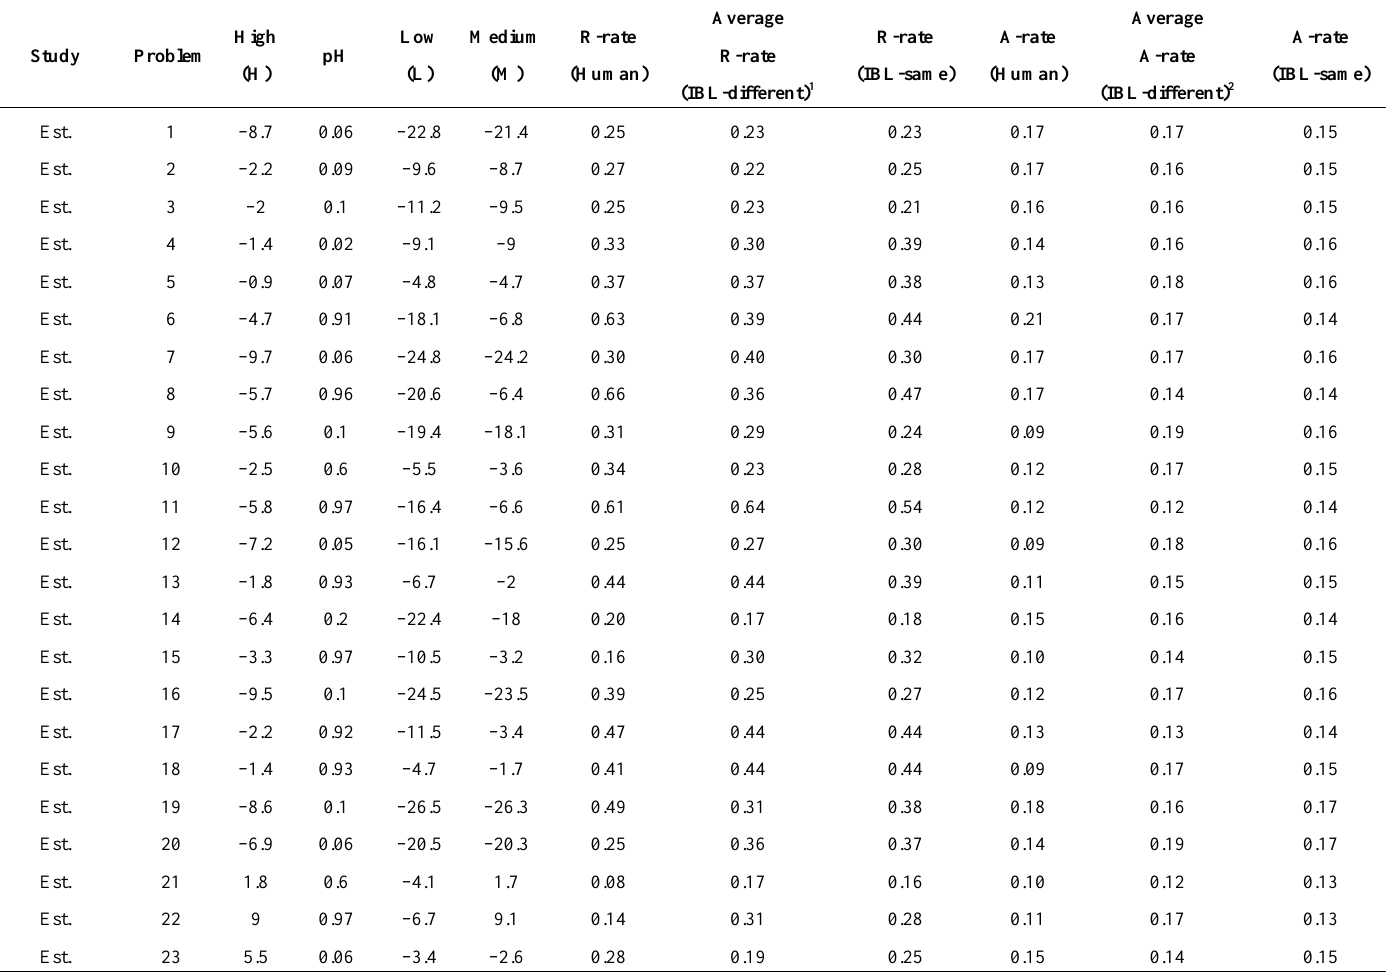
Table A3. The R-rate and A-rate in human data and the IBL-different and IBL-same models across 120 problems in estimation (Est.) and competition (Comp.) study in the